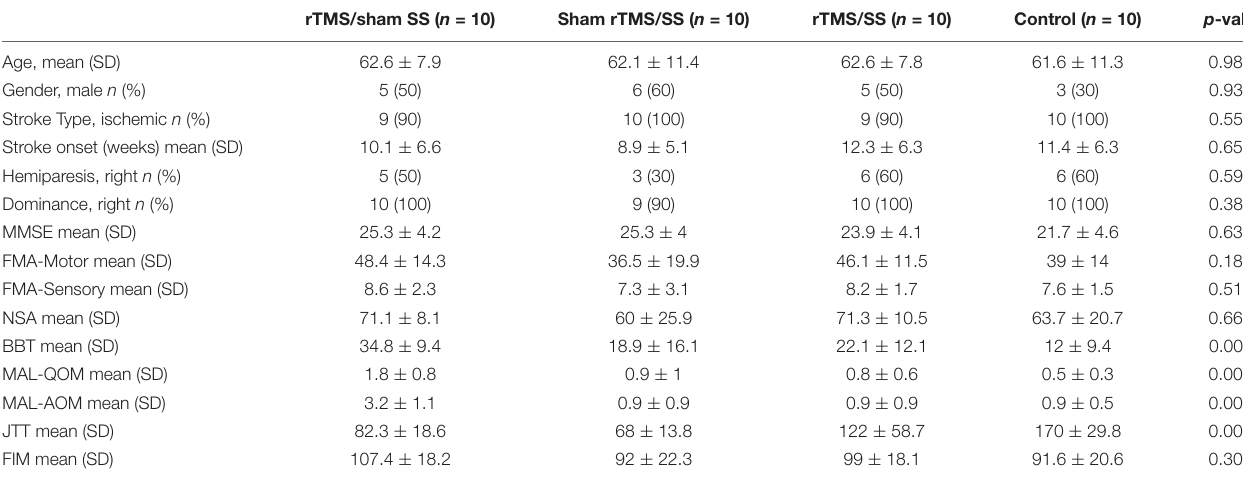
TABLE 1 | Demographic and stroke characteristics for each group at